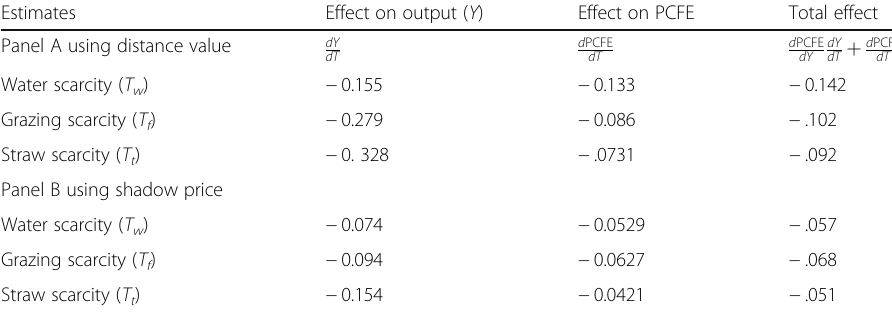
Table 8 Aggregate effect of water and feed scarcity on output, food expenditure, and food